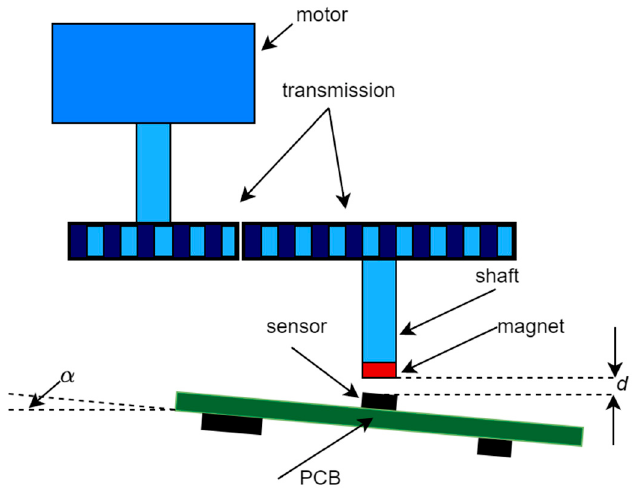
Figure 5. Mechanical diagram of experimental setup.